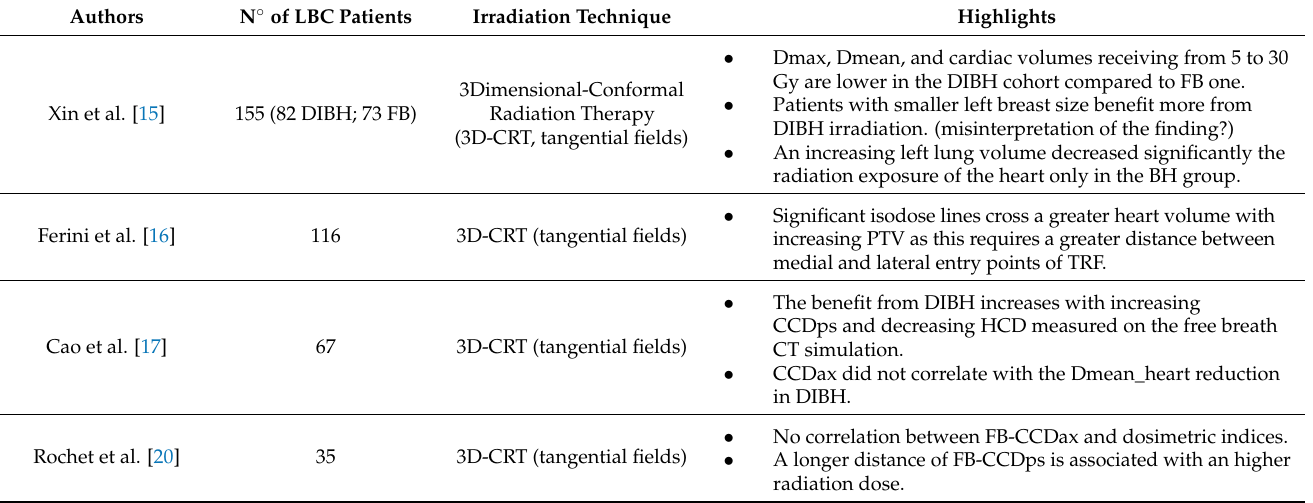
Table 1. The most relevant findings of the above cited